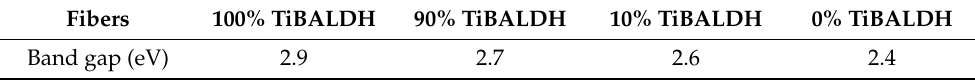
Figure 9. UV–VIS diffuse reflectance spectra of samples after annealing. Table 2. Band gap values for annealed fibers. Table 2. Band gap values for annealed